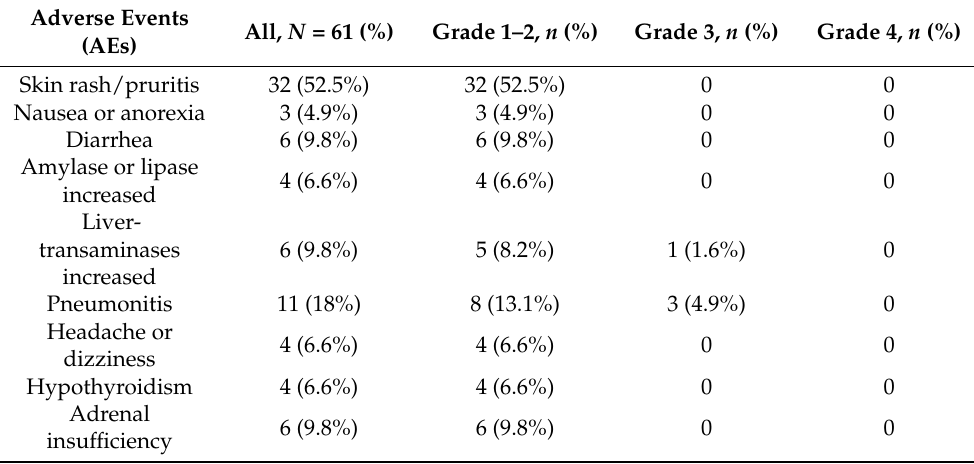
Table 5. Treatment-related adverse events (AEs) of